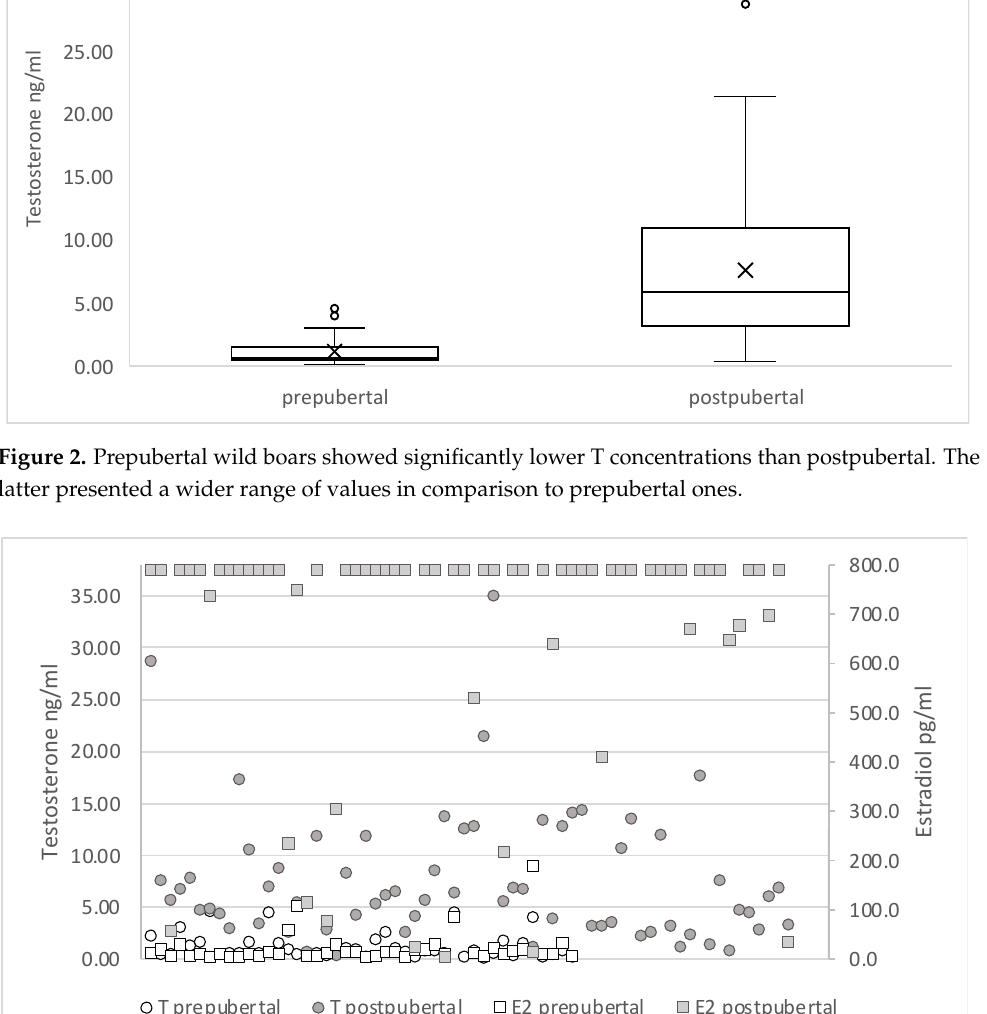
Figure 2. Prepubertal wild boars showed significantly lower T concentrations than postpubertal. The latter presented a wider range of values in comparison to prepubertal ones.